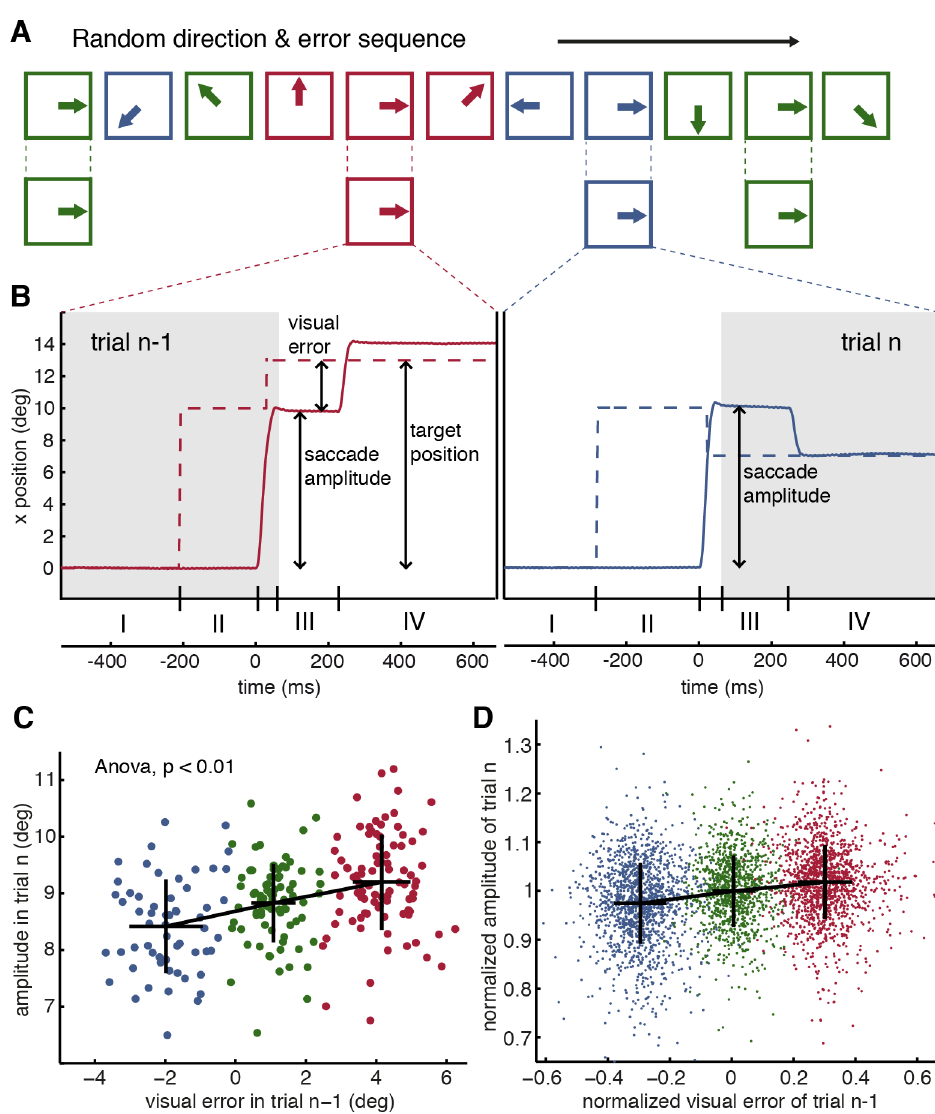
Fig 1. The random error paradigm and its influence on saccade amplitude. A Scheme explaining the selection of trials, considering the type of error and saccade direction in trial n . An arbitrary sequence of trials (first row), represented by boxes, is shown. The direction of the enclosed arrow indicates the direction of the primary saccade in the plane of the screen, and the color depicts the error condition of that particular trial (blue = inward error, green = no error, red = outward error). For the analysis of a particular direction, the sequence is filtered for trials of a specific direction (second row), and following trials are analyzed according to the error condition of the respective trial n − 1. B Trajectories of the visual target (dashed curves) and the changes in eye position they evoked (solid curves) in a sequence of two exemplary trials in which the target stepped out (trial n − 1, red traces) or in (trial n ) during the primary saccade. The numbered intervals at the bottom mark the different periods considered for analysis: I, baseline fixation; II, primary visual error; III, secondary visual error; IV, post correction; the period of the primary saccade falls between intervals II and III. The nonshaded area marks those parts of the trials relevant for transferring error information from trial n − 1 to trial n for the purpose of adapting the primary saccade in trial n . Traces are aligned to the onset of the primary saccade. C Trial-by-trial adaptation in a particular direction (downwards). Data are taken from an exemplary session of monkey H. Saccade amplitude on trial n is plotted over the visual error in trial n − 1; highly negative visual errors correspond to an inward shift of the visual target on trial n − 1 (blue symbols), while highly positive visual errors correspond to an outward shift of the visual target on trial n − 1 (red symbols). The green symbols reflect trials without target shift. In this case, the resulting visual error reflects insufficiencies of the primary saccade. Crosses give the mean and standard deviation for each cluster. The means for the three conditions were significantly different (ANOVA, p < 0.01). D Normalized saccade amplitude as a function of normalized visual error. Population data is based on sessions from all three monkeys, considering only directions with a significant effect